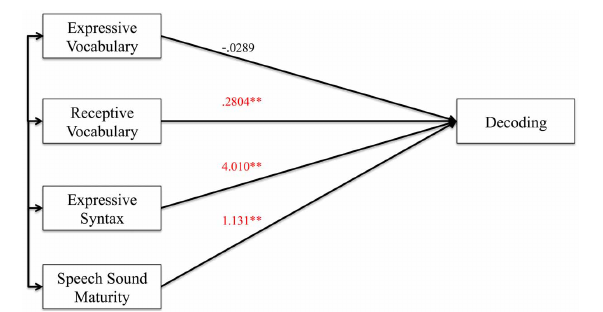
FIGURE 3 | Direct effect model (with mediator) for decoding. Figure 3 shows the direct effect model for preschool language and speech measures on decoding with cognition as the mediator. Unstandardized coefficients of correlations are included in model. Coefficients marked with a double asterisk are significant at the p < 0 . 01 level.